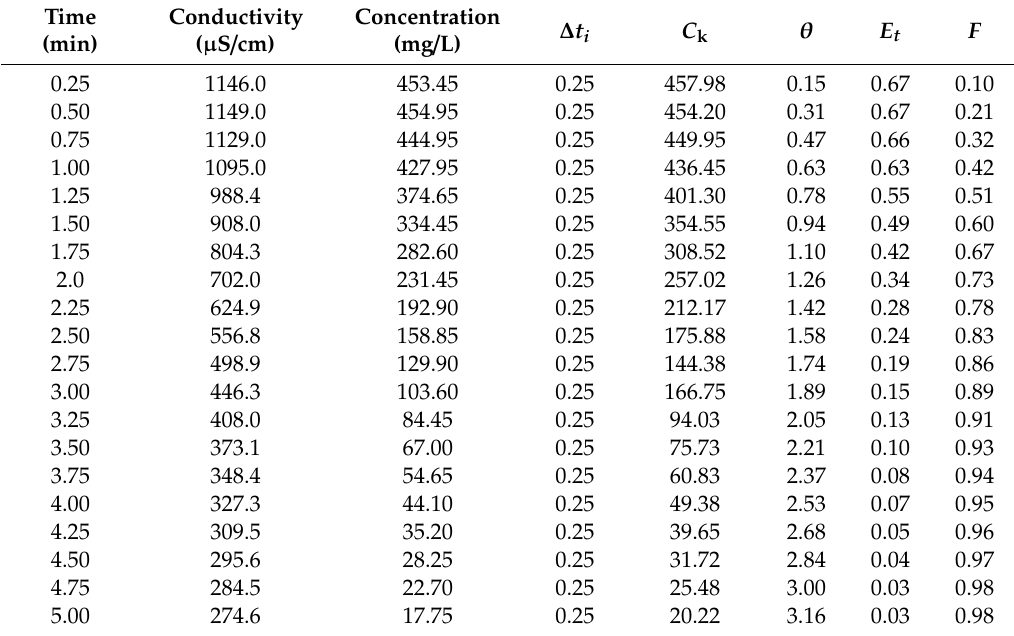
Table 2. Example residence time distribution (RTD) calculations using the method described in